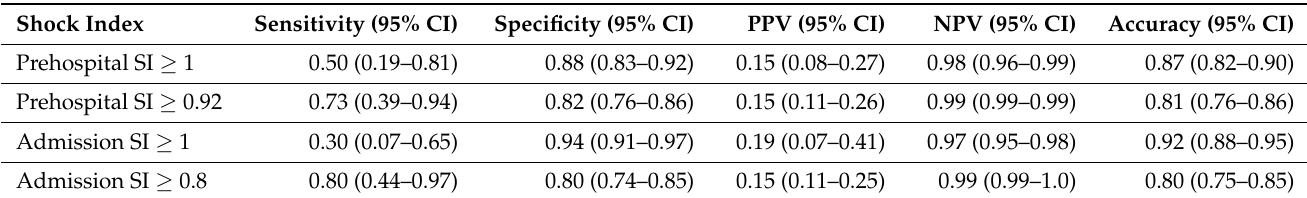
Table 3. Results—Performance of prehospital and on-admission shock index (SI ≥ 1 and SI ≥ value with the best Youden’s index) in the detection of hypofibrinogenemia <1.5 g.L − 1